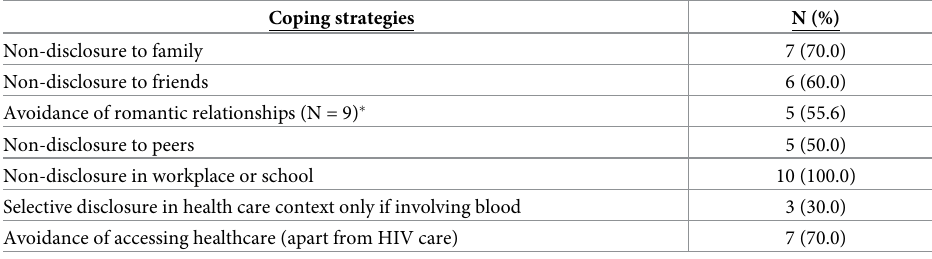
Table 2. Coping strategies of youth participants (N = 10).